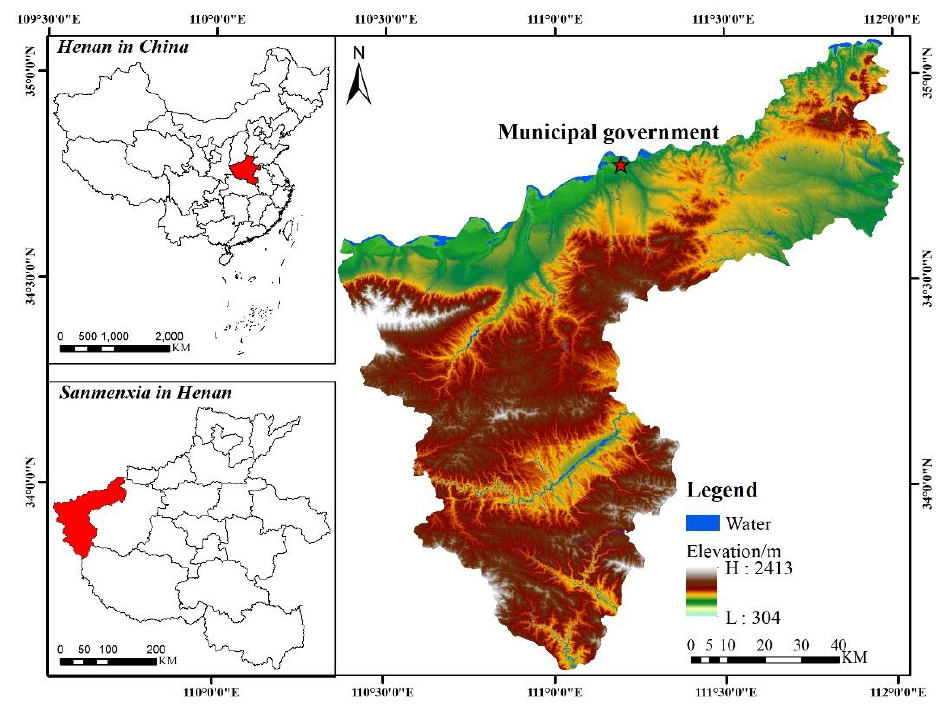
Figure 1. Location of study area. Table 1. Details of all